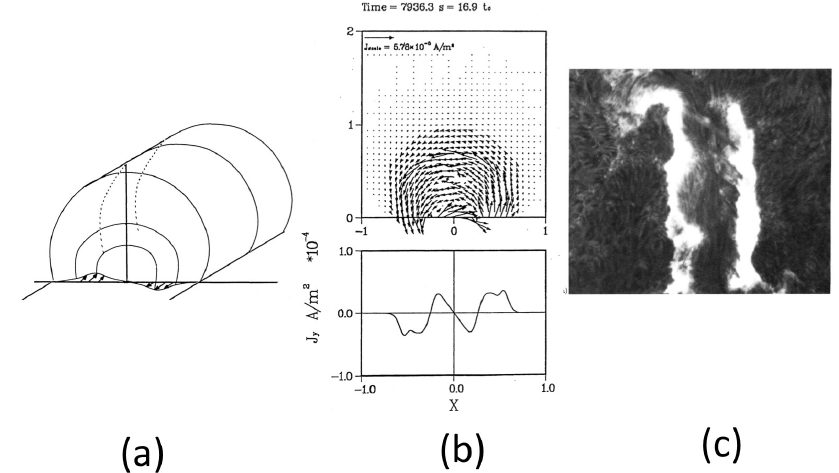
Figure 2. (a) The magnetic arcade with an antiparallel plasma flow in the photosphere. (b) The current distribution in the magnetic arcade (Choe and Lee, 1996a, b). (c) Spotless two-ribbon flare (courtesy of H. Zirin,